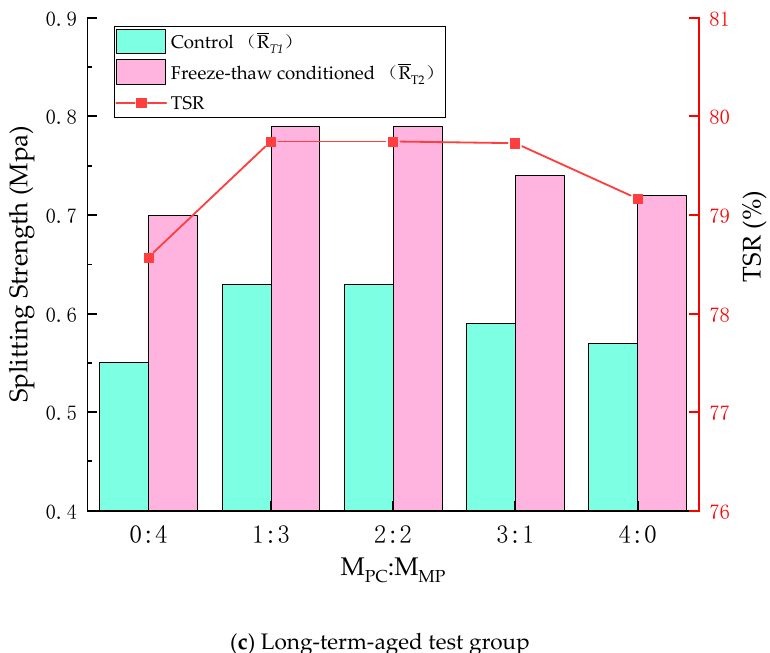
Figure 6. Results of the freeze–thaw splitting test of asphalt mixture under different aging conditions.